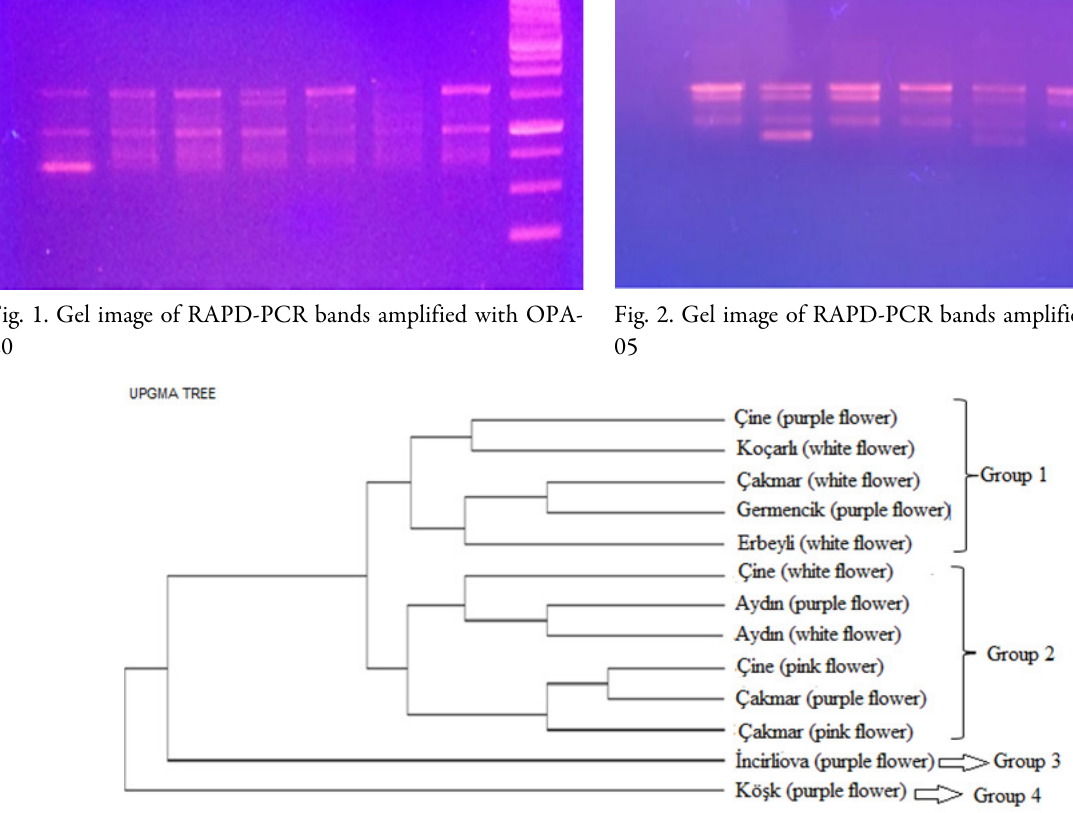
Fig. 3. The UPGMA tree generated using RAPD data of Vitex agnus-castus Table 3. Pairwise genetic distance matrix obtained from PCR with RAPD primers Populations